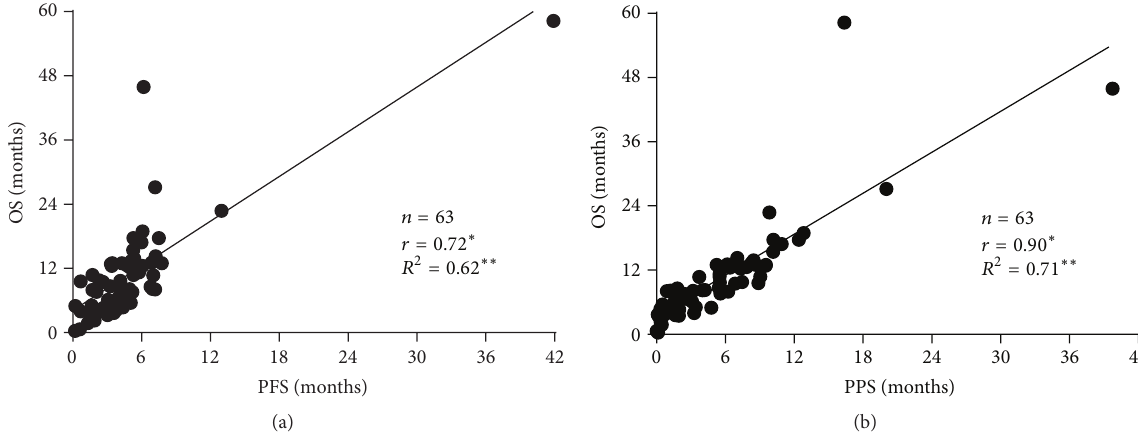
Figure2:(a)Correlationbetweenoverallsurvival(OS)andprogression-freesurvival(PFS).(b)Correlationbetweenoverallsurvival(OS)and postprogression survival (PPS). ∗ The 𝑟 values represent Spearman’s rank correlation coefficient. ∗∗ The 𝑅 2 values represent linear regression.